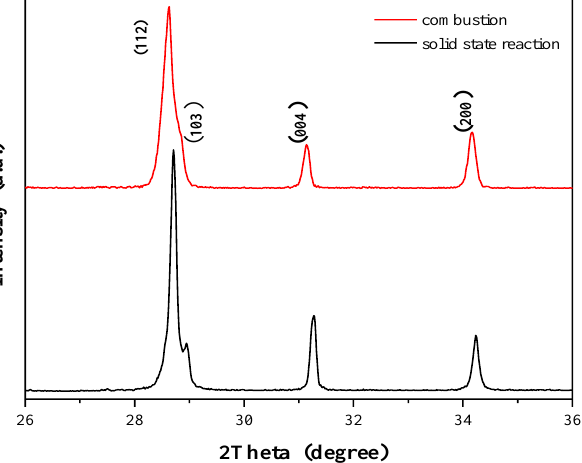
Figure 6. XRD patterns of CaMnGdMoWO samples when x = 0.2500 and y = 0.0020 obtained by solid-state reaction method (black line) and combustion route (red line) within the range of 2 Θ from 26.0 to 36.0°.